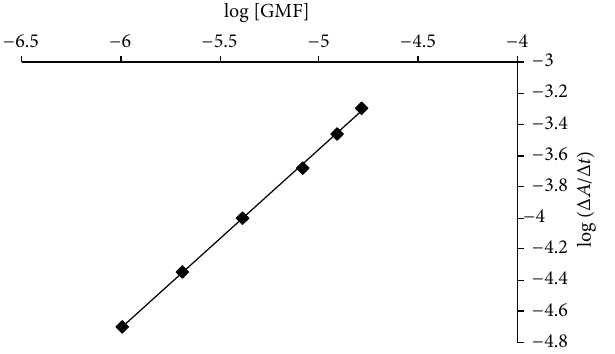
Figure 7: Calibration plot of logarithm rate of the reaction against logarithm molar concentration of GMF for rate data method.